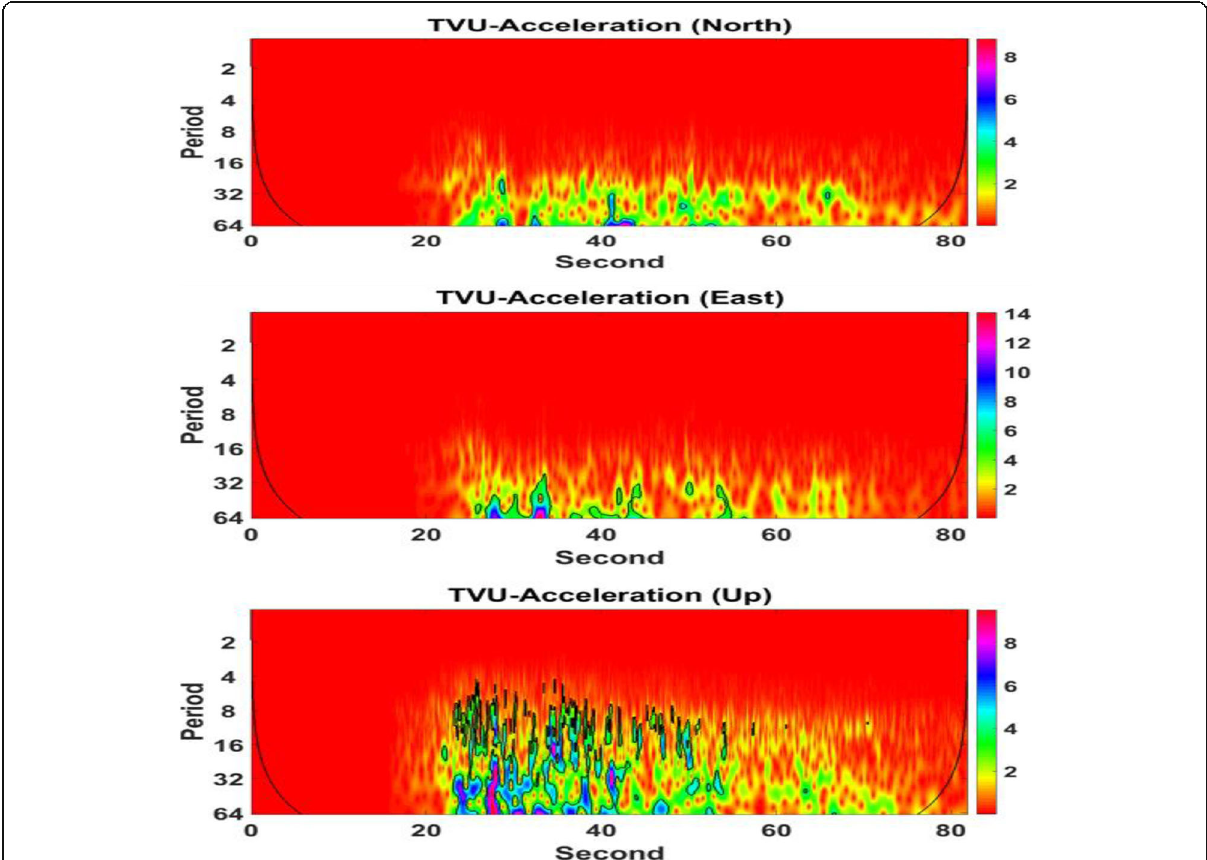
Fig. 8 Two Dimension CWT-Scalogram ground motion from NS, EW, and Vertical record (0 – 80 s) at TVU